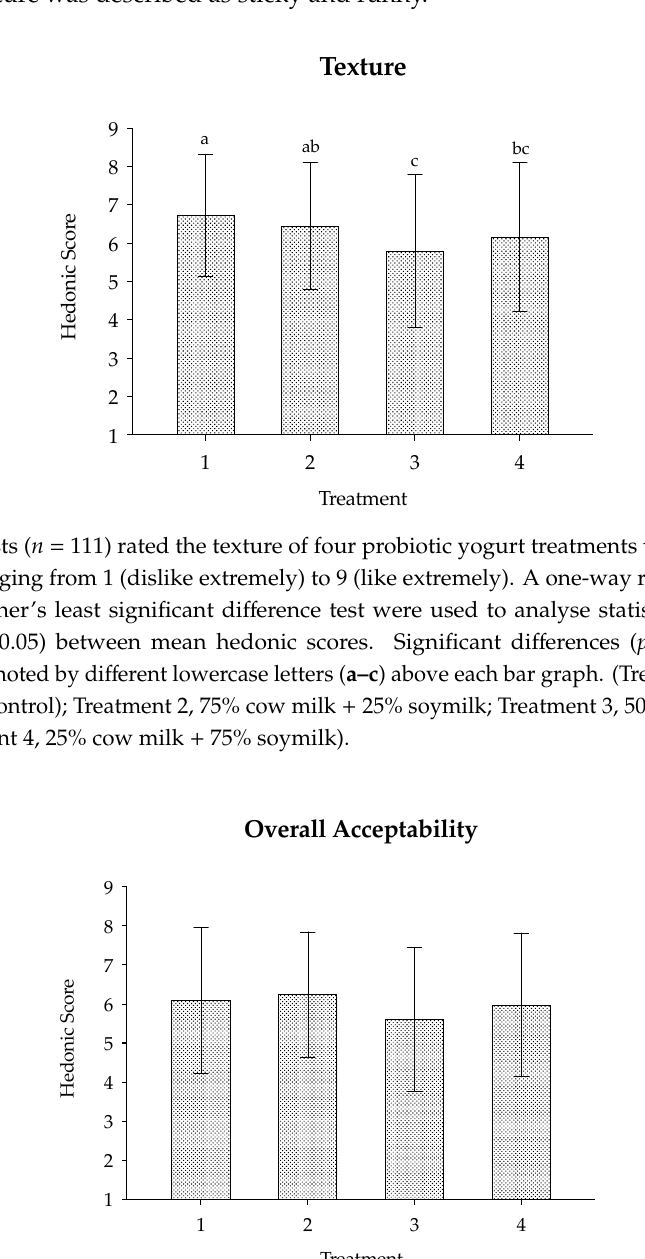
Figure 4. Panellists ( n = 111) rated the overall acceptability of four probiotic yogurt treatments using a nine-point hedonic scale ranging from 1 (dislike extremely) to 9 (like extremely). A one-way repeated-measures ANOVA and Fisher’s least significant difference test were used to analyse statistically significant differences ( p < 0.05) between mean hedonic scores. (Treatment 1 indicates 100% cow milk (control); Treatment 2, 75% cow milk + 25% soymilk; Treatment 3, 50% cow milk + 50% soymilk; Treatment 4, 25% cow milk + 75% soymilk).